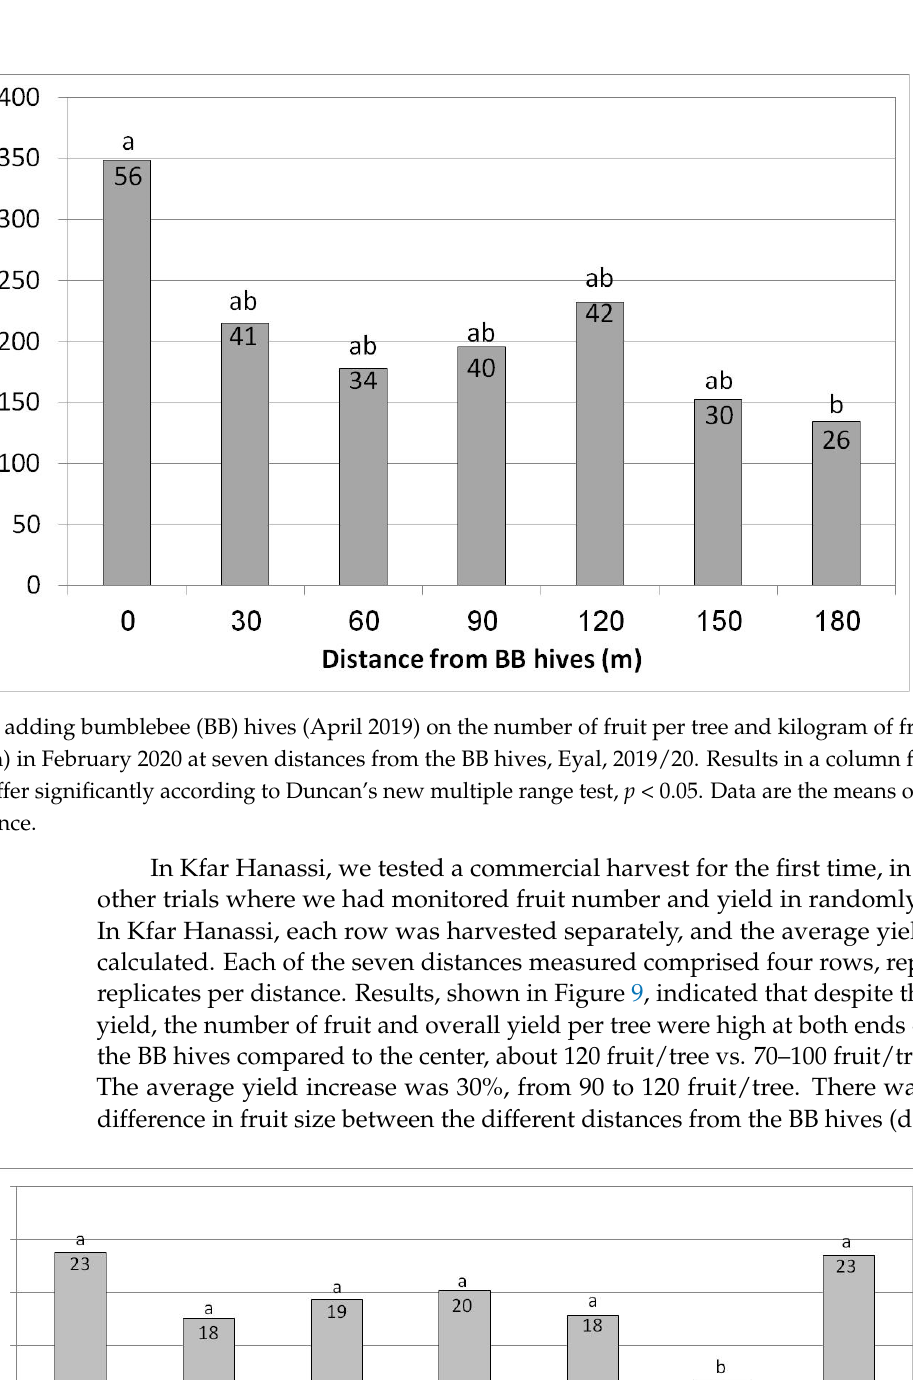
Figure 9. Effect of adding bumblebee (BB) hives (April 2019) to both sides of the orchard on the number of fruit per tree and kilogram of fruit per tree (no. in the column) in February 2020 at seven distances from the BB hives, Kfar Hanassi, 2019/20. Results in a column followed by different letters differ significantly according to Duncan’s new multiple range test, p < 0.05. Data are the means of 120 ‘Hass’ trees per distance (30 trees/row × 4 rows).